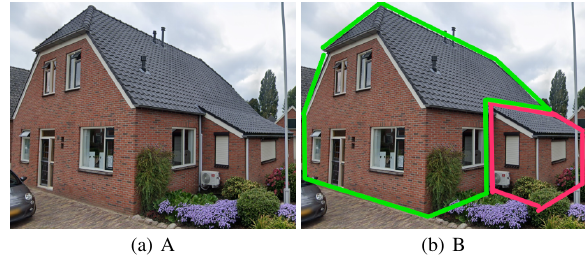
Figure 5. Example of number of storeys (2) of a building Number of Storeys